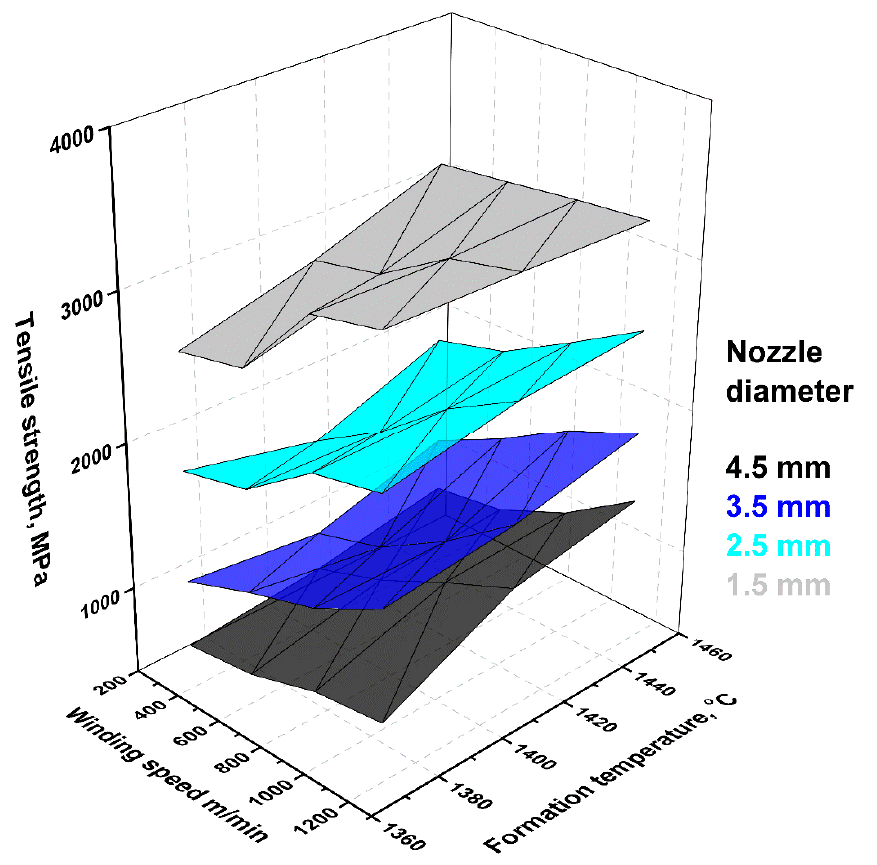
Figure 6. The dependence of tensile strength of the obtained basalt continuous fibers on winding speed and formation temperature.